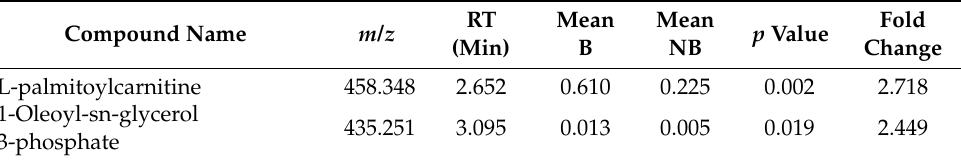
Table 3. Identification of differentially expressed lipids detected in the scent glands during the breeding and non-breeding seasons in the negative ion mode of